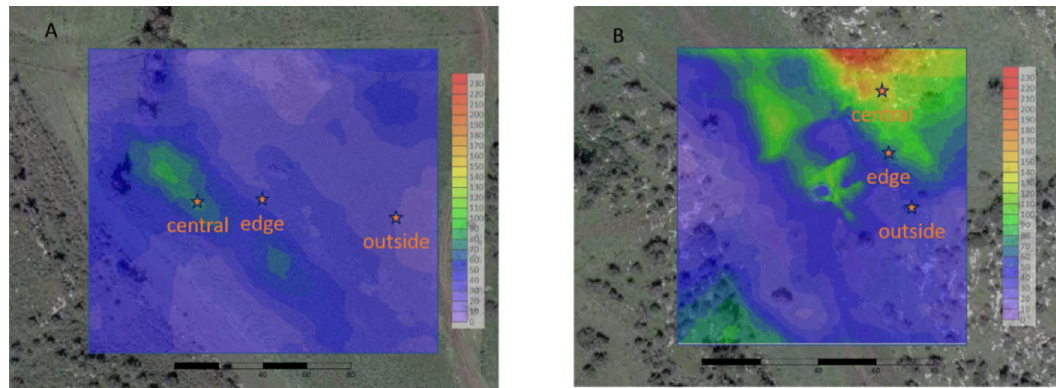
Figure 8. Orto-photo map and EC measurements by the FDEM showing leakage in abandoned ( A , left) and active ( B , right) corrals at the Beit Nir site.